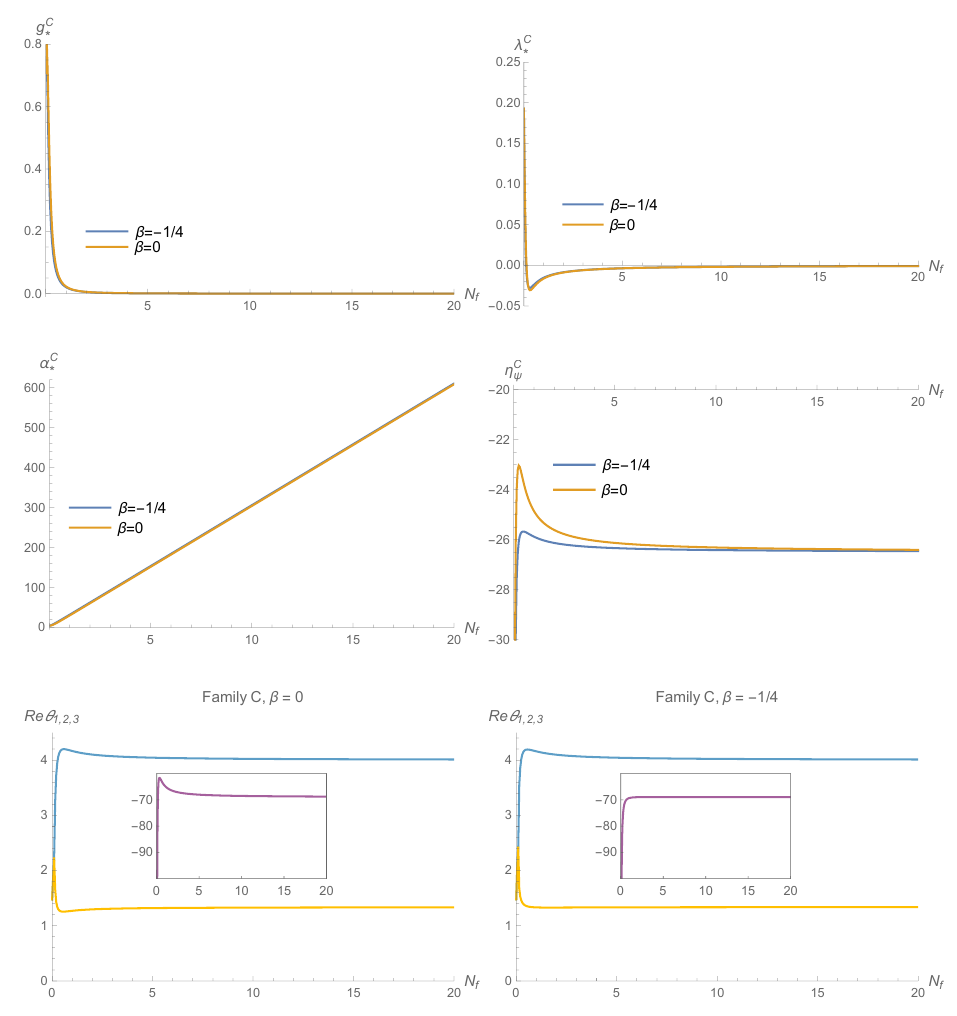
Figure 10. Characteristic properties of Family C obtained from investigating the system Equations (26) and (29) numerically. The first three diagrams show the position of the fixed points as a function of N f for β = − 1/4 (blue line) and β = 0 (orange line). NGFP C exists for all values N f and is fairly insensitive to the choice of β . It is unaffected by the window (55). The fermion anomalous dimension at the fixed points is depicted in the fourth diagram, showing that it is negative and rather large. The stability analysis identifies two UV-attractive and one UV-repulsive stability coefficient, indicating that NGFP C is a saddle point in the { g , λ , α }